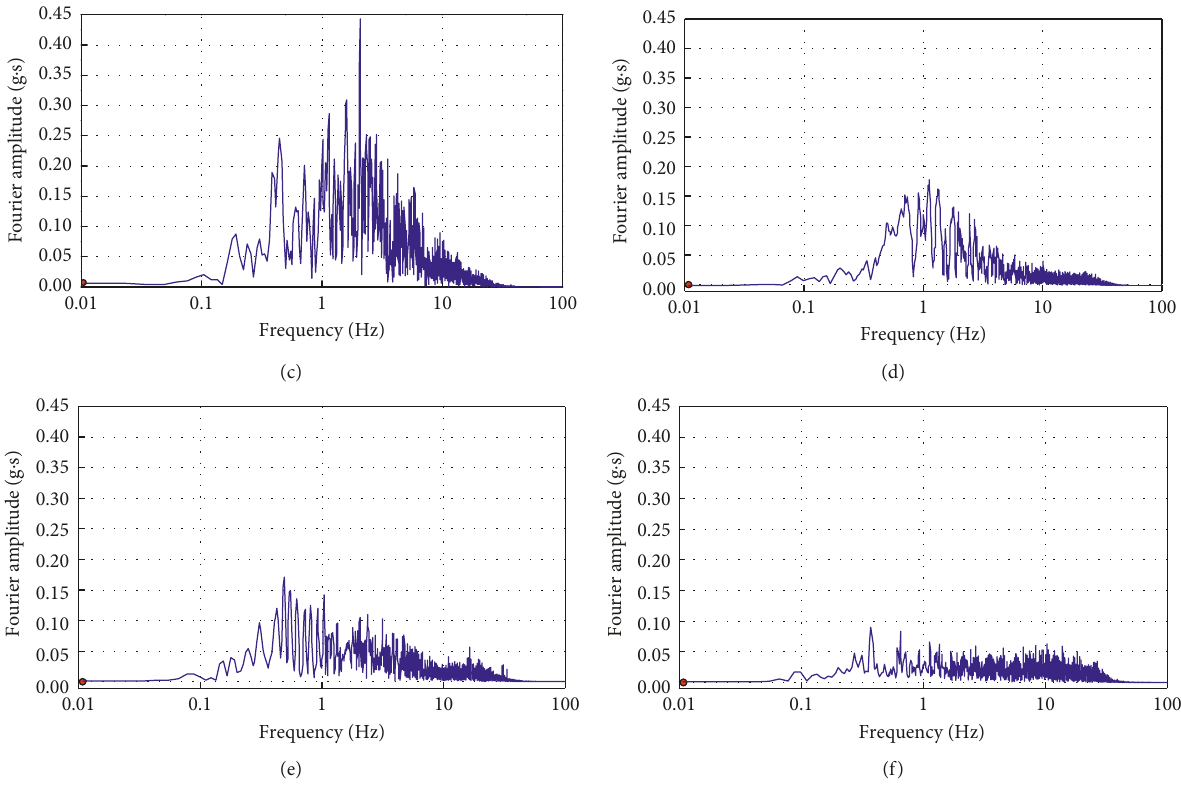
Figure 17: Fourier spectrum of the pile. (a) 0.35g. (b) 0.40g. (c) 0.45g. (d) 0.50g. (e) 0.55g. (f) 0.60 g.